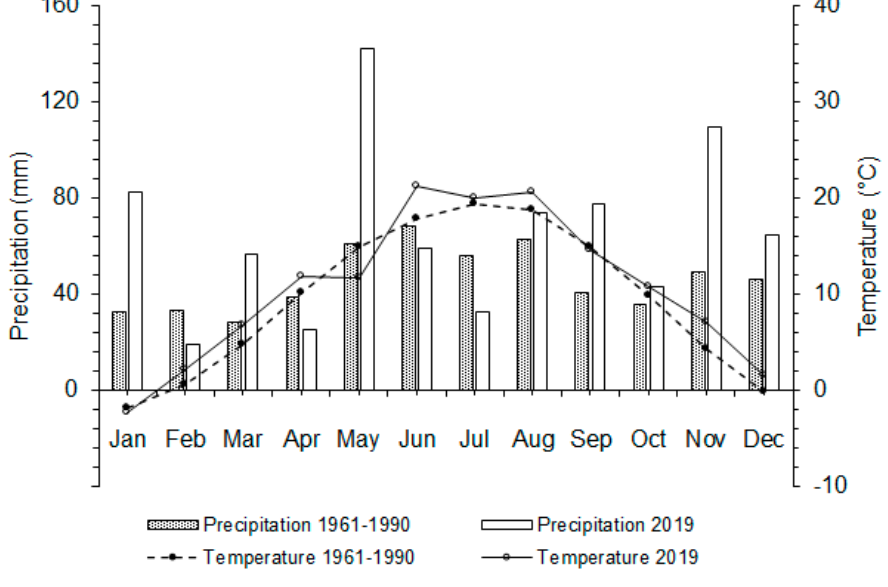
Figure 1. Precipitation and mean air temperatures for years 1961–1990 and 2019.